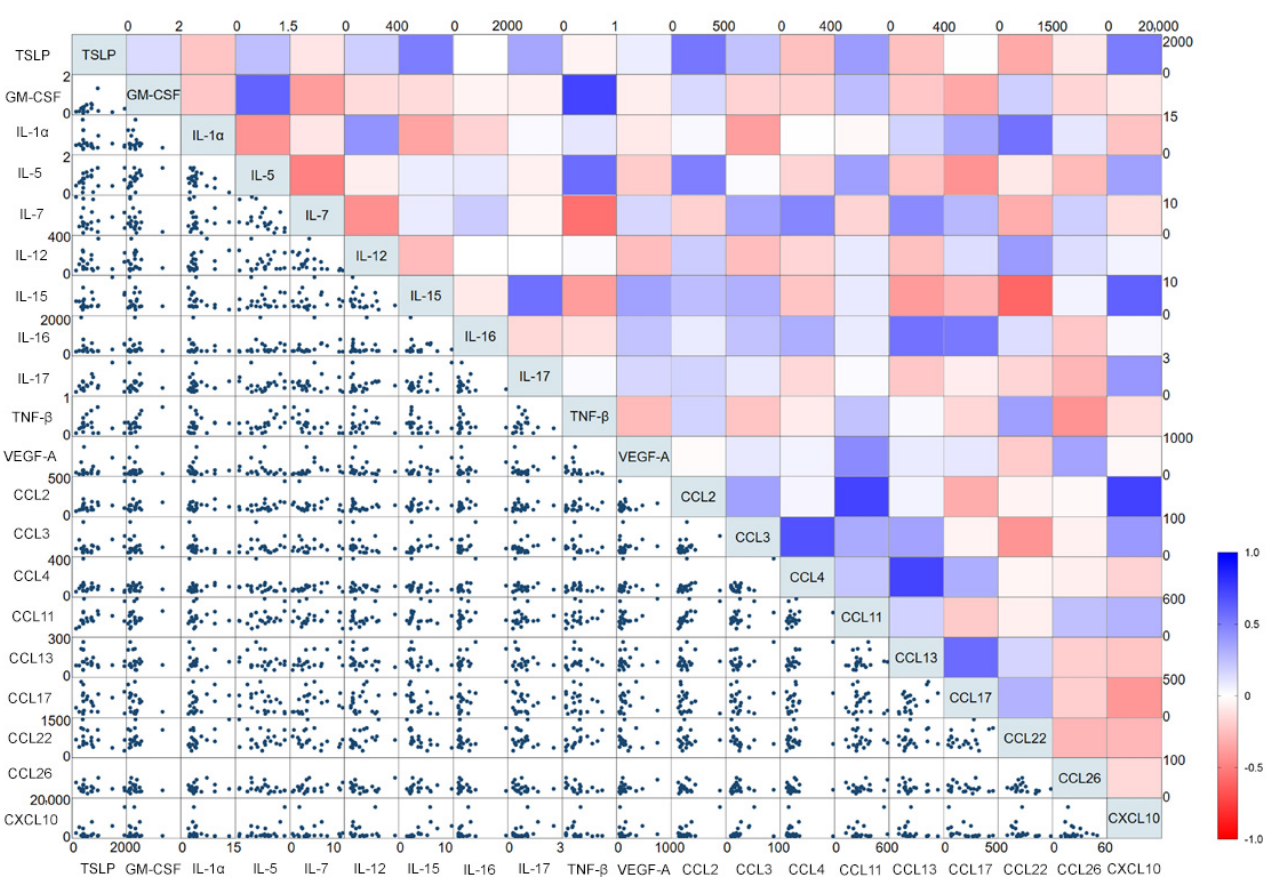
Figure 2. Correlation between plasma TSLP and other cytokines. Bivariate scatterplots of continuous variables are presented below the diagonal; heatmap generated from the Spearman’s correlation coefficients ( ρ ) with corrections for multiple comparisons (Šidák’s correction) are above the diagonal. Units shown are in pg/mL.